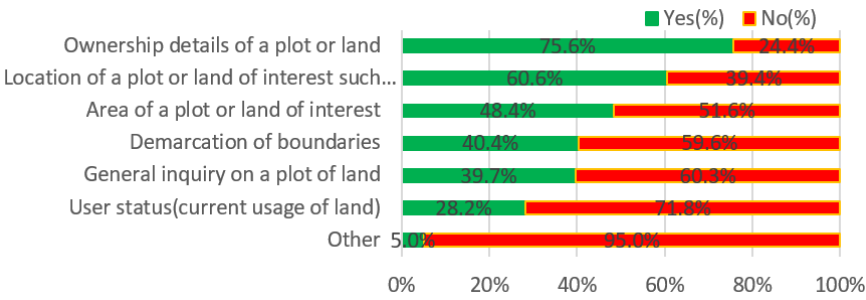
Figure 3. Type of details on the plot of land of interest ( n = 401).